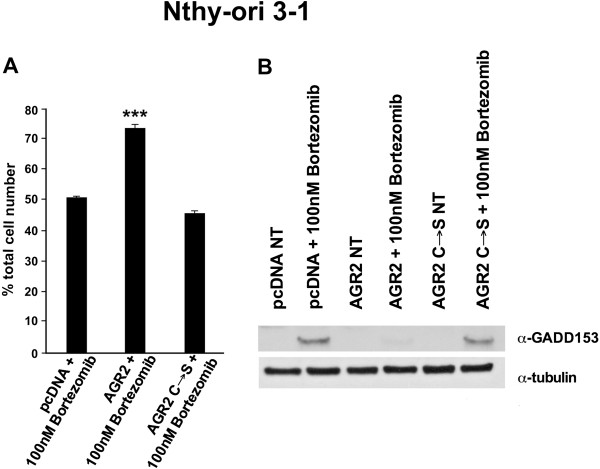
Effects of Bortezomib in Nthy-ori 3–1 cells ectopically expressing AGR2. A) Nthy-ori 3–1 cells transfected with AGR2, AGR2 (C → S) or with the empty vector (pcDNA) were treated for 24 hours with Bortezomib 100 nM. After treatment, cells were collected by trypsinization and counted in triplicate. The percentage of total cell number respect to untreated cells is reported ± standard deviations. B) Nthy-ori 3–1 cells transfected with AGR2, AGR2 (C → S) or with the empty vector (pcDNA) were treated for 24 hours with Bortezomib 100 nM. After treatment, cells were lysed, and protein lysates were subjected to immunoblotting with the indicated antibodies. Asterisks indicate P < 0.001 (***).